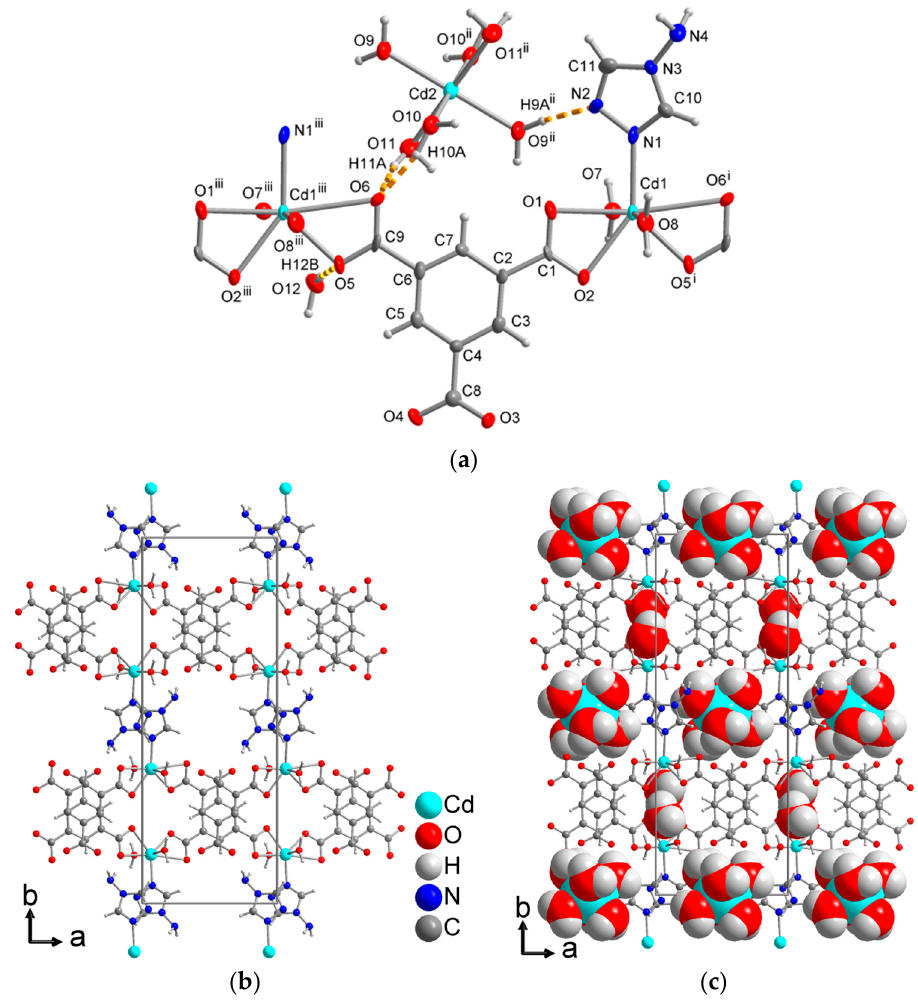
Figure 1. ( a ) Extended asymmetric unit of 1 (70% thermal ellipsoids, hydrogen atoms with arbitrary radii), showing also part of the hydrogen bonds (orange dashed lines). Symmetry transformations i = x + 1, y , z ; ii = – x + 1, − y + 1, − z + 1; iii = x − 1, y , z . Section of the packing diagram of ( b ) the anionic chains and ( c ) the full structure with the [Cd(H 2 O) 6 ] 2+ cations and the crystal water molecules highlighted in space-filling mode. Selected distances and angles are given in Table 1 and details of H-bonds in Table 2.